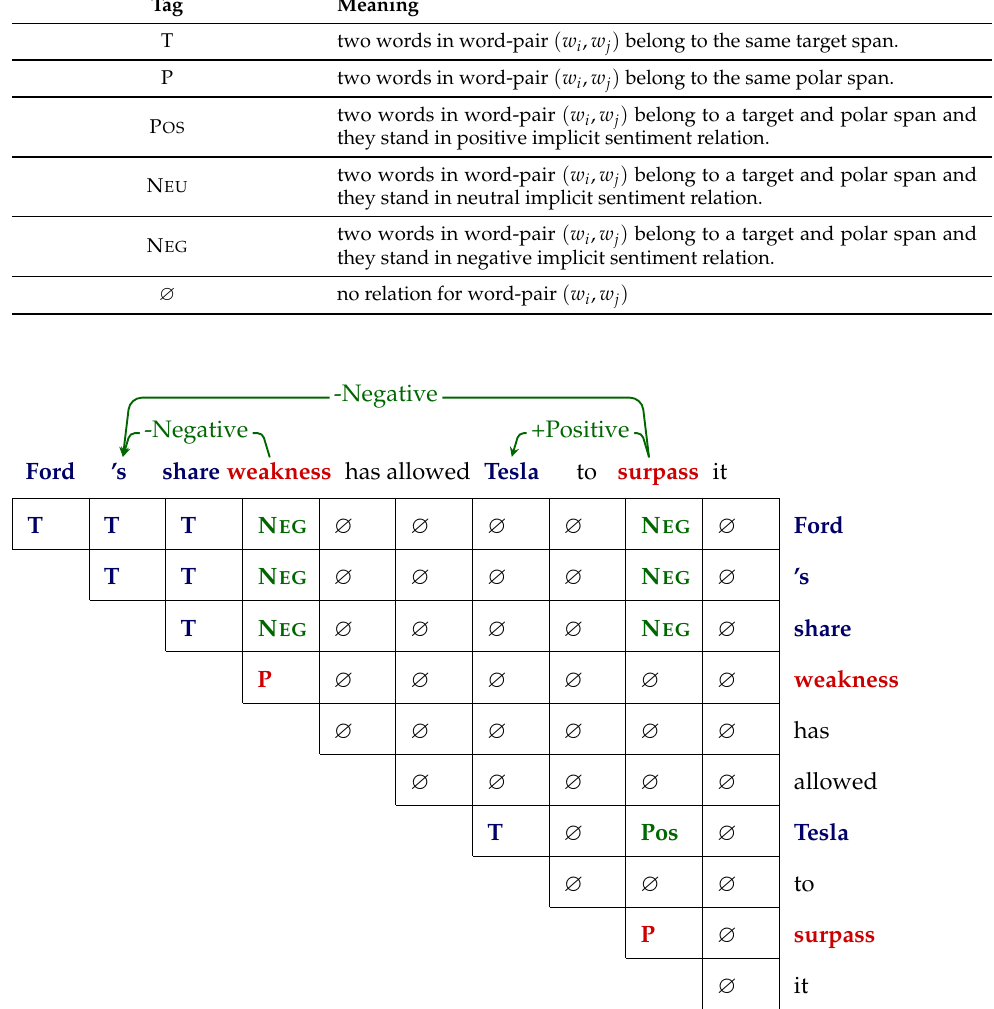
Figure 6. A grid-tagging example for the triplet extraction task. (Reproduced from Wu et al. [15] with a SENTiVENT corpus